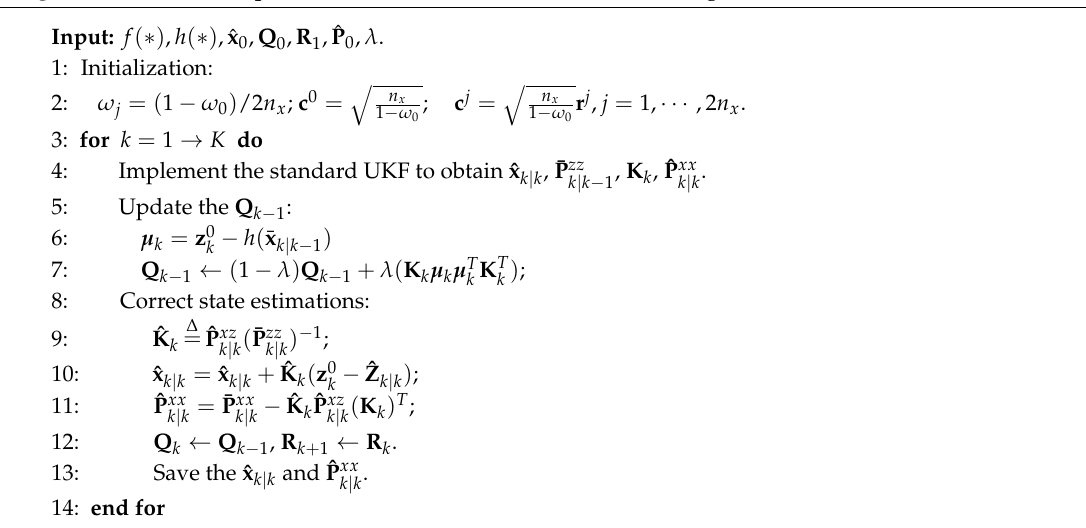
Algorithm 1: The adaptive Unscented Kalman filter (AUKF)